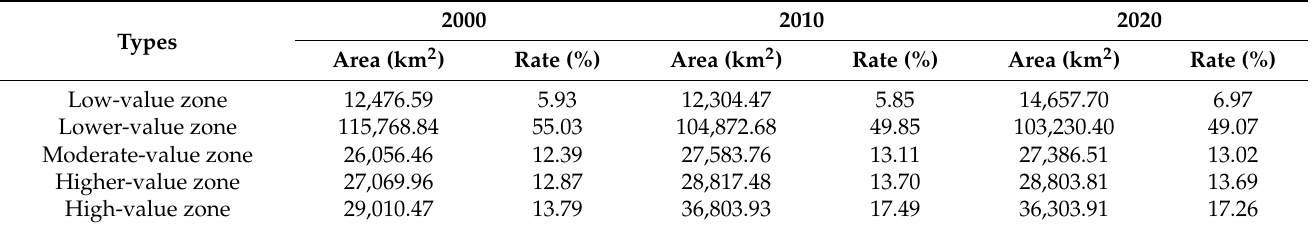
Table 5. Distribution of EEQ grades of the